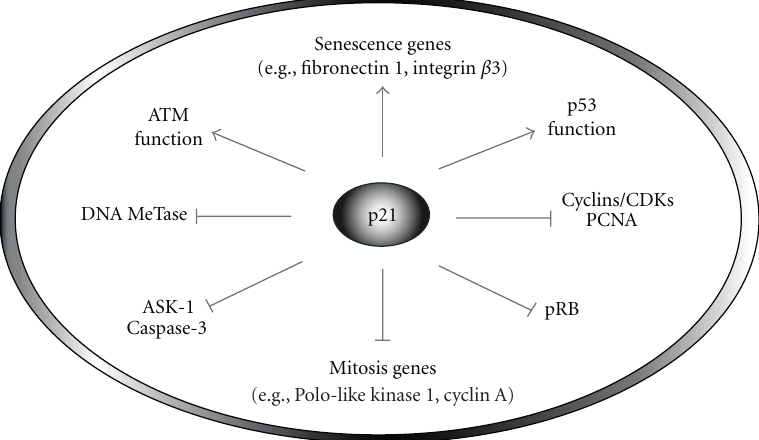
Figure 2: Multiple functions of the p21 tumor suppressor. This protein plays a crucial role in the p53 signaling pathway owing to its ability to inhibit cell cycle progression (e.g., by interacting with PCNA and cyclin/CDK complexes), influence gene expression indirectly, through interfering with DNA methyltransferase (MeTase) activity, and directly, by controlling the transcription of genes involved in senescence and mitosis, down-regulating apoptosis (e.g., through interaction with ASK-1), and positively regulating ATM and